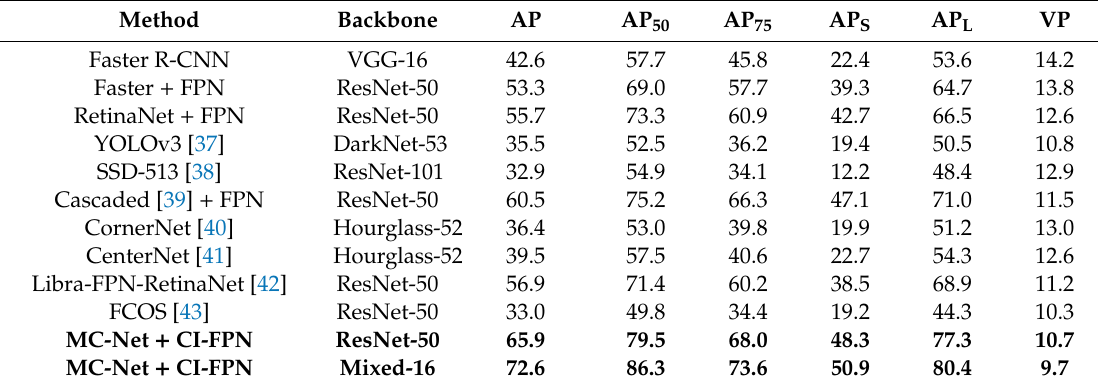
Table 4. Accuracy of di ff erent detectors on FBDF testing